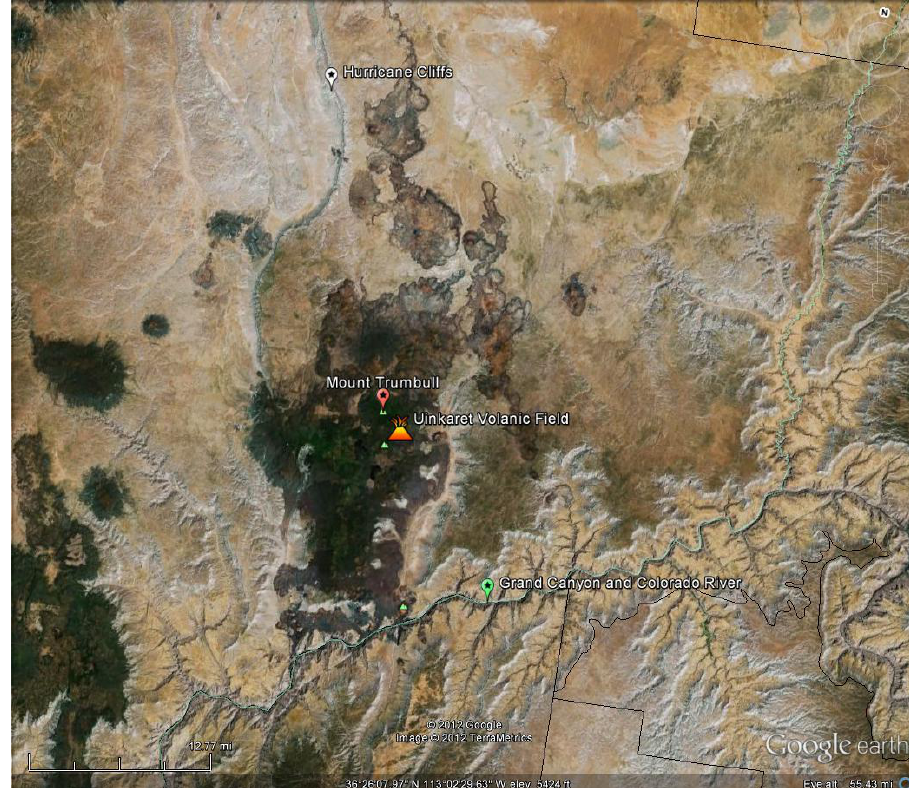
Figure 15. The Uinkaret Volcanic Landscape, Grand Canyon, and Colorado River.